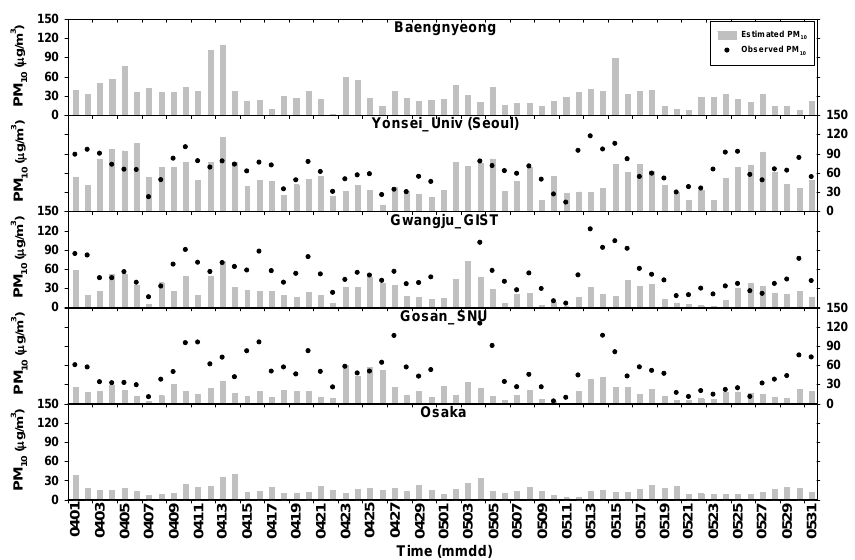
Fig. 8. Observed PM 10 (black dots) vs. estimated PM 10 (grey bars). Daily averaged estimated PM 10 was converted from the assimilated AOD values at five AERONET sites. 24h PM 10 was measured at three AERONET sites (Yonsei_Univ (Seoul), Gwangju_GIST, and